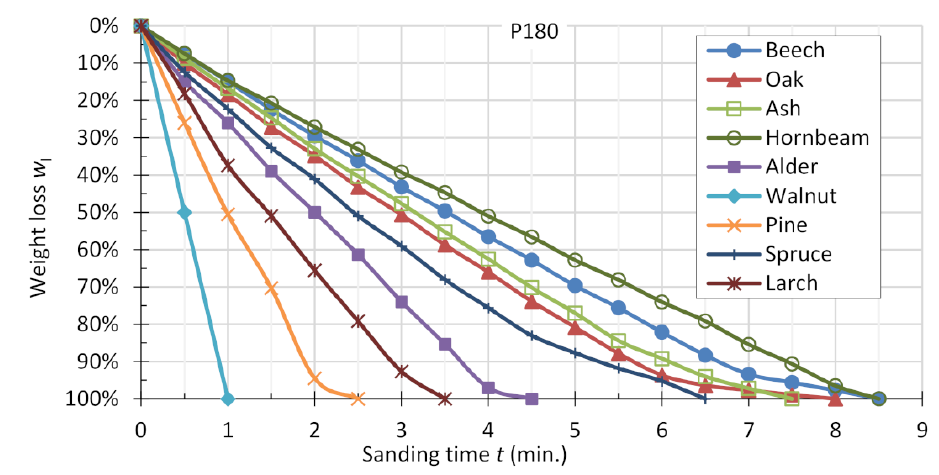
Figure 8. Average percentage weight loss of specimens sanded with abrasive belt